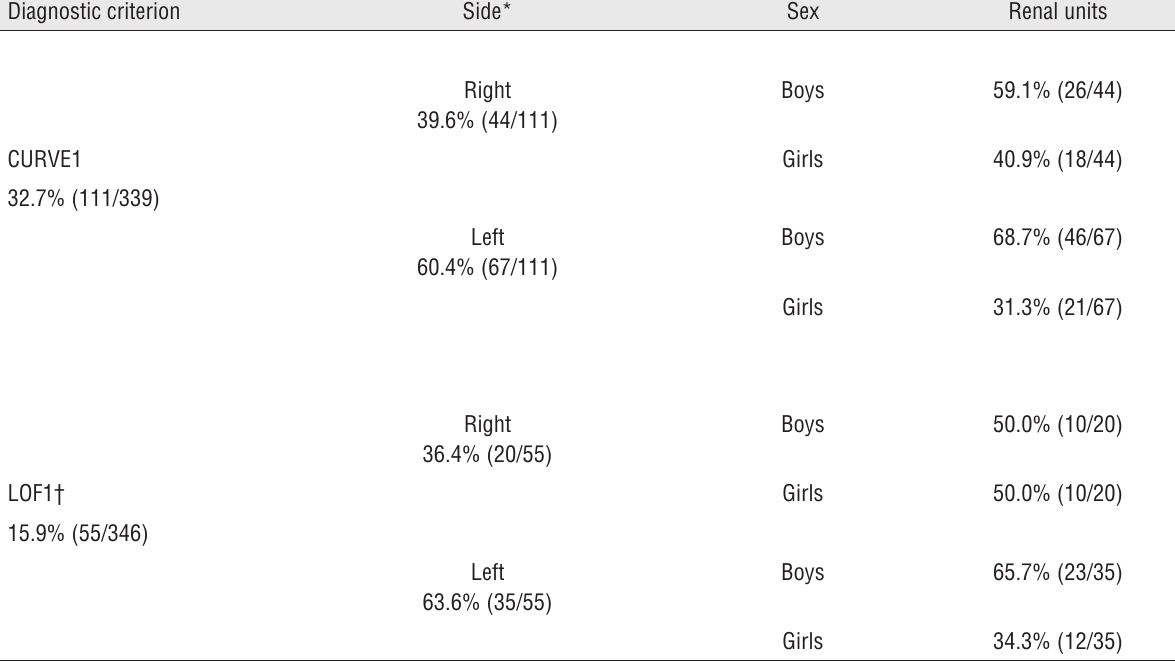
cURvE1: renal curves in the first scan. LOf1: output fraction in the first